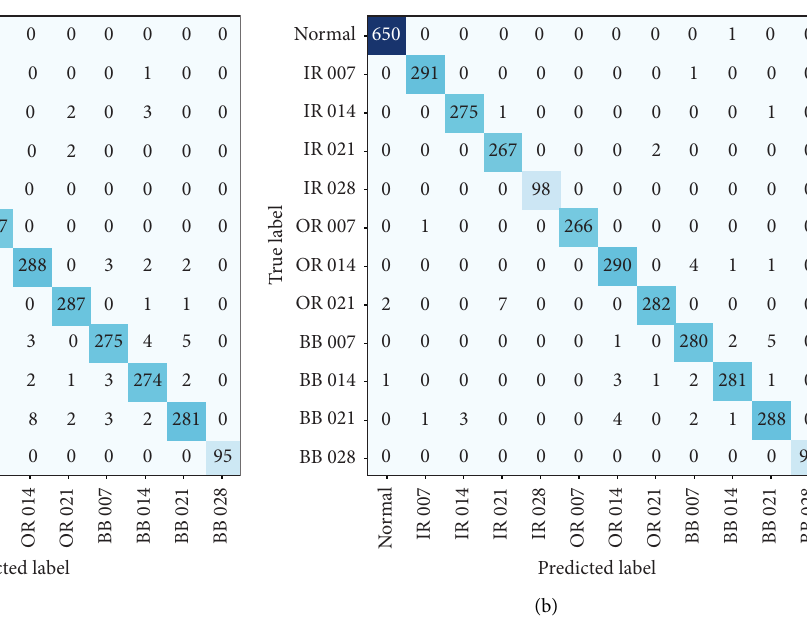
Figure 4: Confusion matrices for Exp. 2 using multiboost +PART on the test dataset (a) with T30 and (b) with T30 ∗